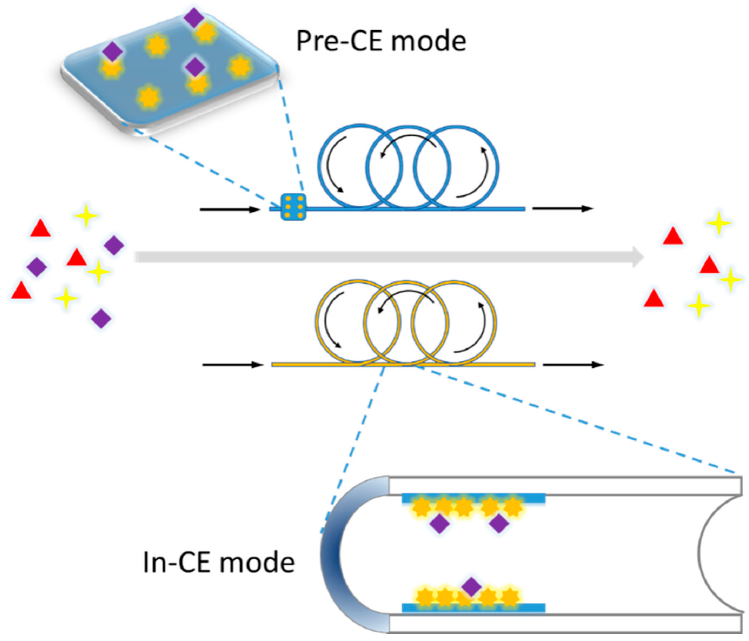
Figure 3. Scheme of capillary electrophoresis based ligand fishing.